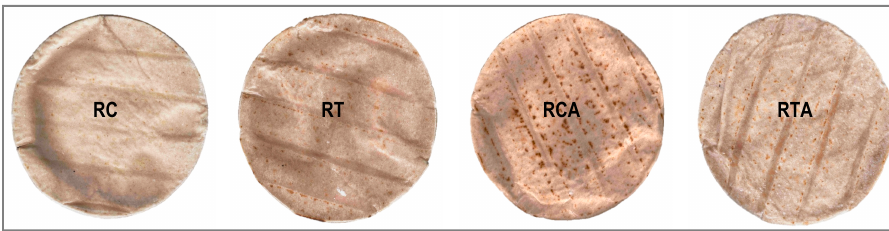
Figure 1. Images of the four experimental GF flat breads.